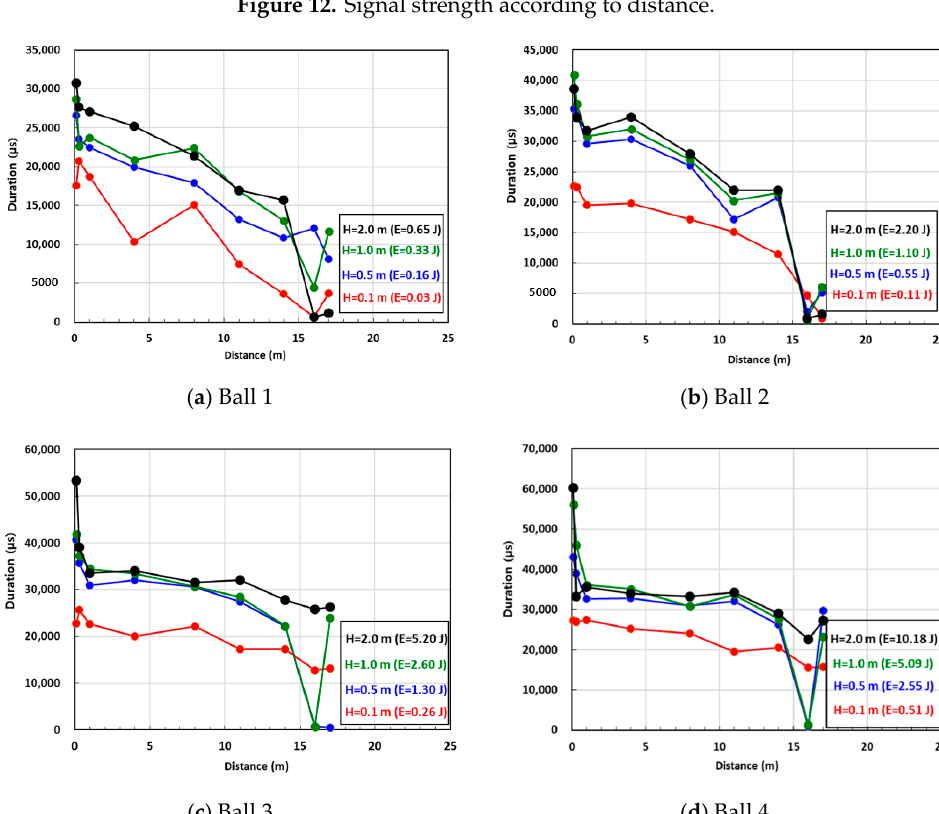
Figure 13. Duration according to distance.